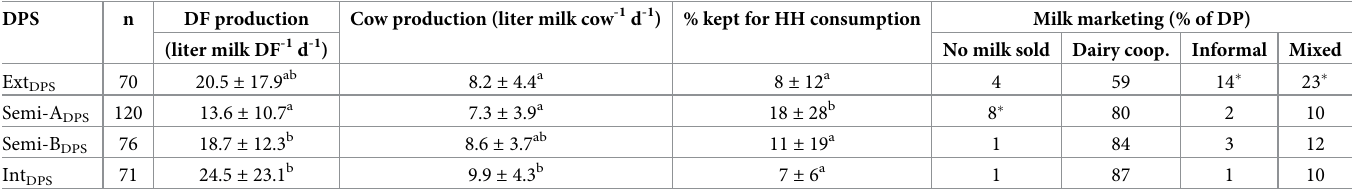
Values within a column with different superscript letters differs significantly (P < 0.05). � Frequency within a column differs significantly from overall frequency (P <